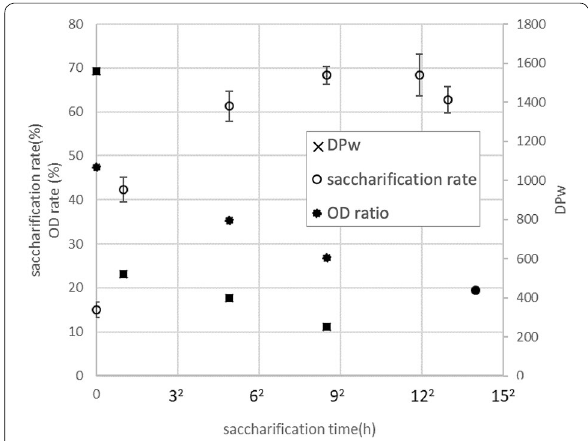
Fig. 2 Saccharification rates, weight-averaged degrees of polymerization (DP w s), and OD ratios for bagasse cellulose hydrolyzed using Accellerase 1500. Open circles are saccharification rates, filled circles are OD ratios, and crosses are DP